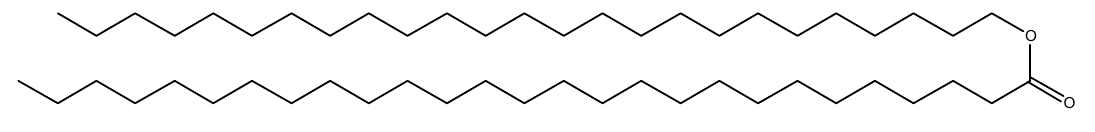
Figure 1 : Chemical structure of pentacosyl heptacosanoate ( 1 ). Figure 1. Chemical structure of pentacosyl heptacosanoate ( 1